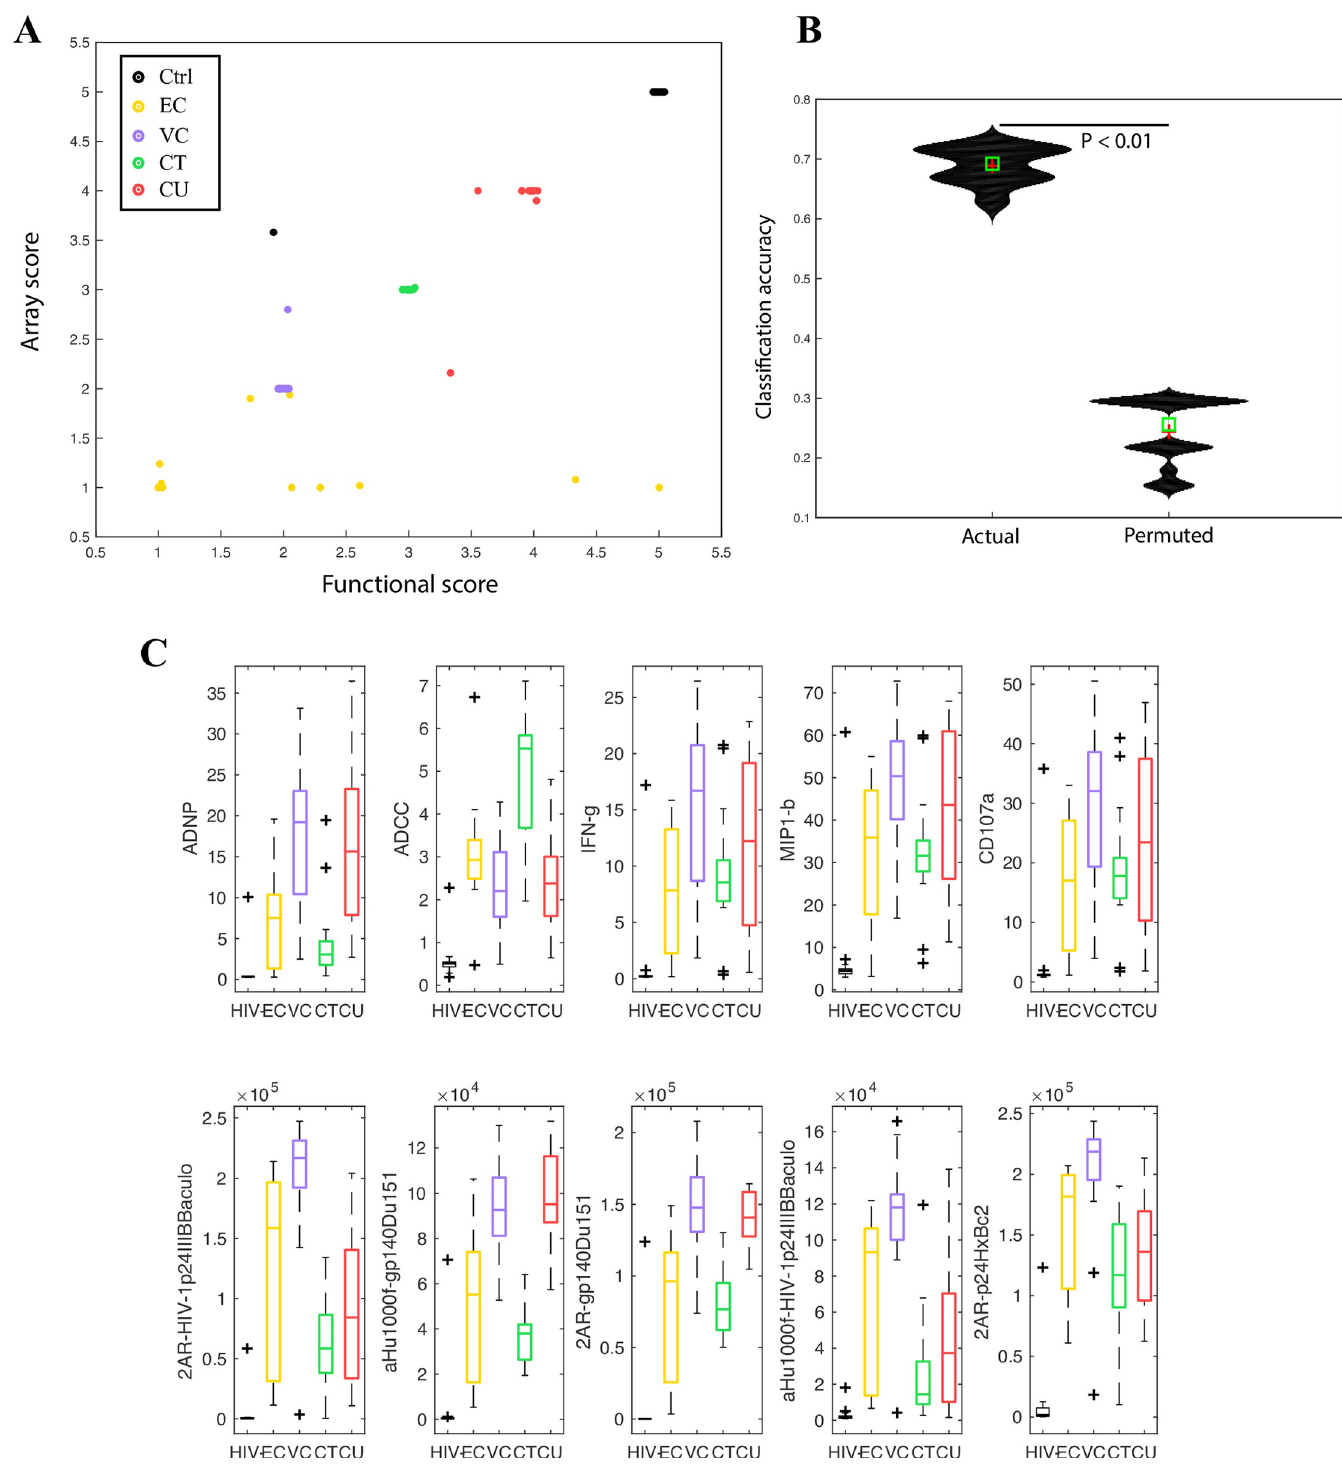
Fig 1. Humoral response profiles can accurately distinguish clinical phenotypes. A. Bi-plot showing how a classifier built on functional (Fc effector function) and array/biophysical data can discriminate between subjects across 5 different HIV clinical phenotypes. The scores on each axis are obtained from a corresponding random forest model. The X axis scores are from a random forest model built on functional data, the Y axis scores are from a random forest model built on array/biophysical data. B. Violin plots showing classification accuracy of the random forest model from 1A on real and permuted data, as measured in a 5-fold cross validation framework (i.e., with data from some subjects blinded/held out as described in the Methods). Exact P value calculated using a permutation test (P < 0.01) confirms significance of model. C. Boxplots illustrating distributions of the humoral responses that are most predictive/discriminative across the 5 clinical phenotypes.